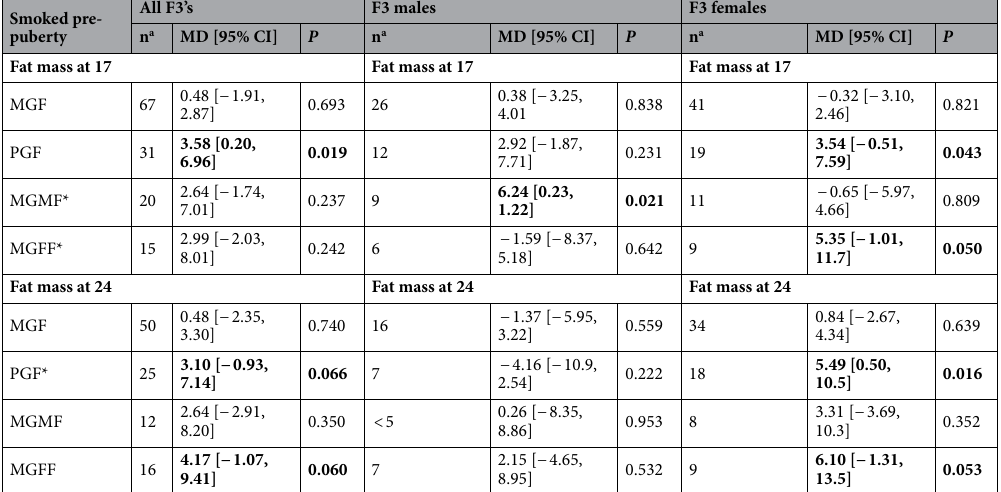
Table 3. Unadjusted associations between fat mass of the F3 population according to whether their grandfathers or great-grandfathers had started smoking regularly before the onset of puberty (< 13). Comparisons are with all ancestors who had started smoking between ages 13 and 16. P values in bold are using 1-tailed tests since the hypothesis was that there would be excess fat mass for early smokers. MD, mean difference; CI, confidence interval; MGF, maternal grandfather; PGF, paternal grandfather; MGMF, maternal grandmother’s father; MGFF, maternal grandfather’s father. a The number of grandchildren and great-grandchildren whose ancestor started smoking regularly < 13 years. *Statistically significant interaction between the sexes.